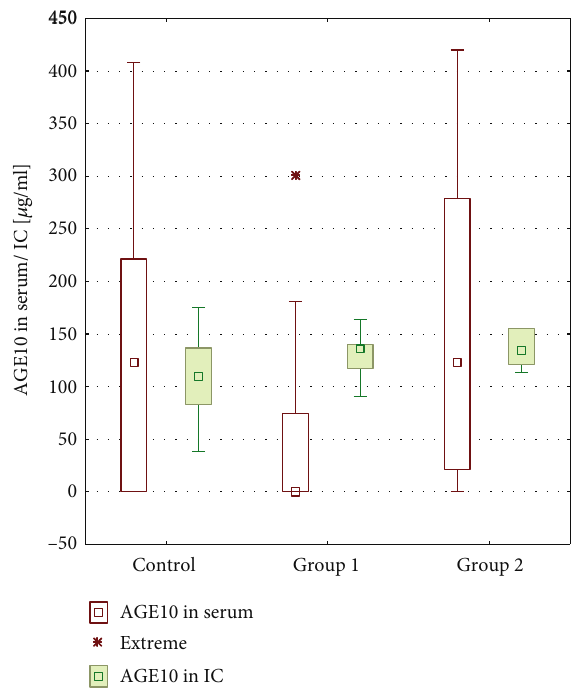
Figure 2: Immune complexes AGE10-anti-AGE10 in patients ’ sera. For comparison, free noncomplexed AGE10 is shown in the blank